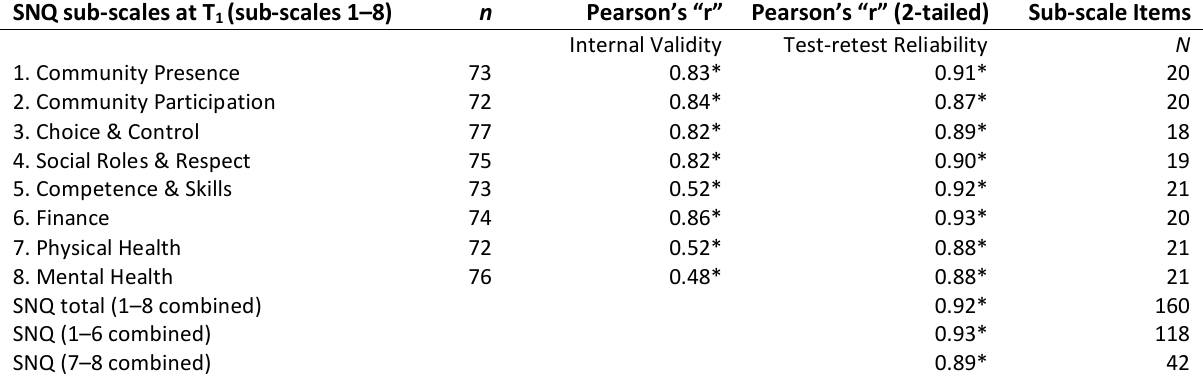
Table 4. Internal construct validity and test-retest reliability for SNQ sub-scales and SNQ total. SNQ sub-scales at T 1 (sub-scales